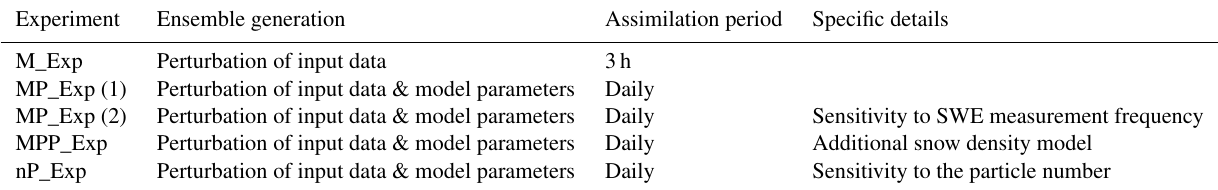
Table 5. List of multivariate DA experiments.